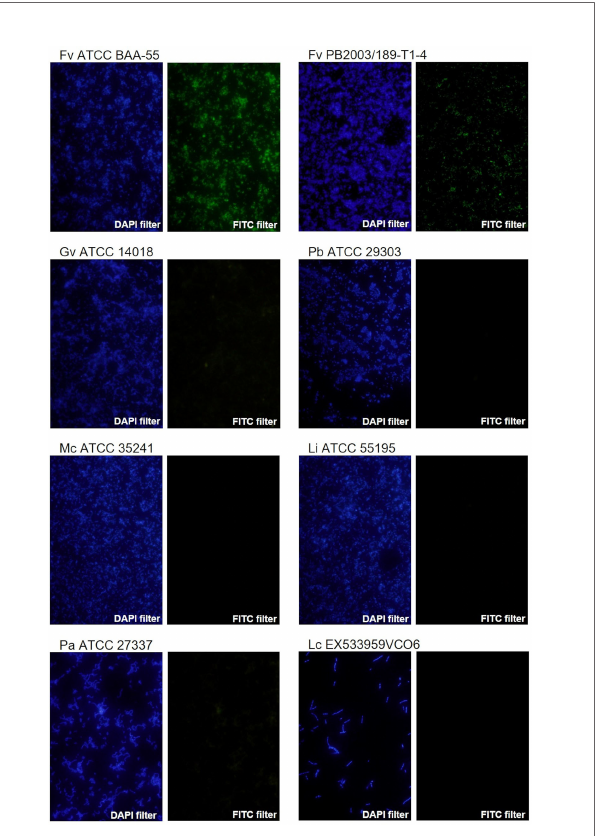
FIGURE 1 | Examples of fl uorescence microscopy results using the novel PNA probe with F. vaginae strains and other BV-related species. F. vaginae ATCC BAA-55 (good hybridization), F. vaginae PB2003/189-T1-4 (poor hybridization), G. vaginalis ATCC 14018, P. bivia ATCC 29303, M. curtisii ATCC 35241, L. iners ATCC 55195, P. anaerobius ATCC 27337 and L. crispatus EX533959VCO6 (absence of hybridization). For each strain/species an image